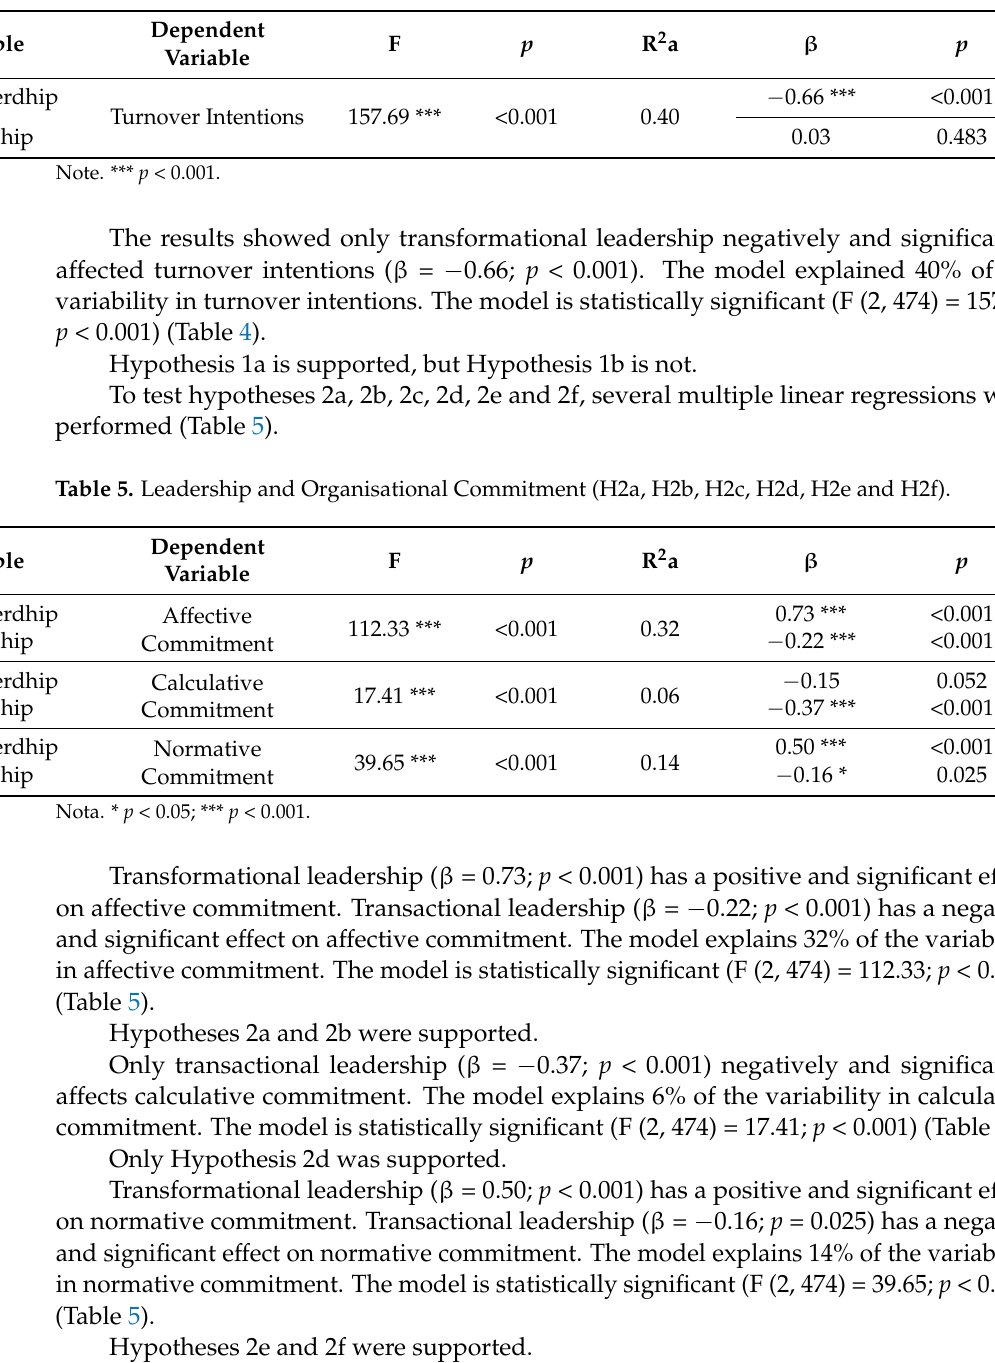
Table 4. Leadership and Turnover Intentions (H1a and H1b).